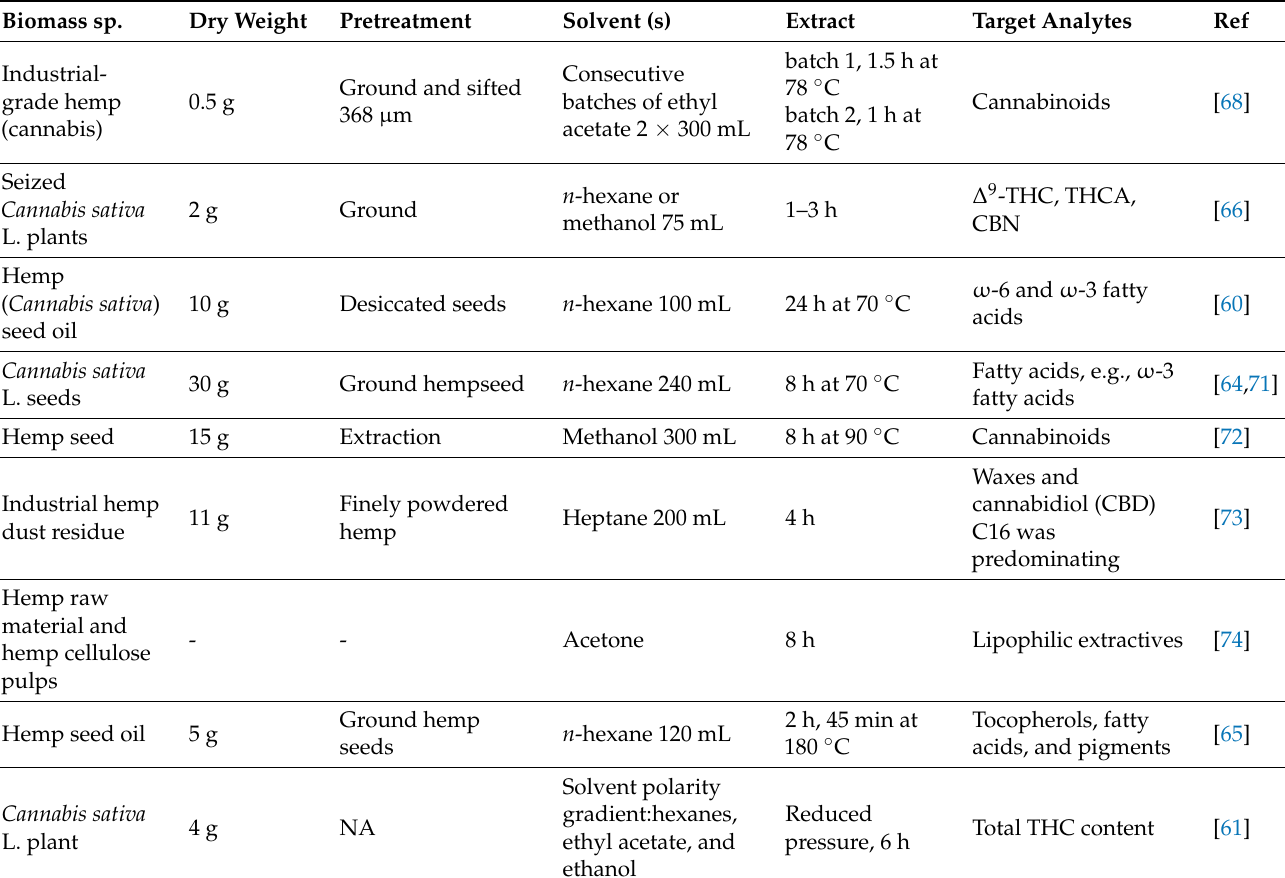
Table 2. Recent research on the extraction of various compounds from Cannabis sativa L. using the Soxhlet method. Biomass